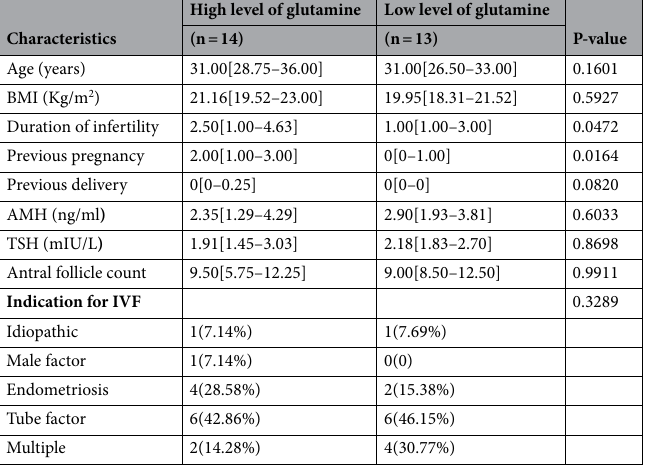
Table 2. Characteristics of patients assessed for follicular fluid analysis. Data are median (interquartile range (IQR)) or numeric value (%). AMH anti-Mullerian hormone.